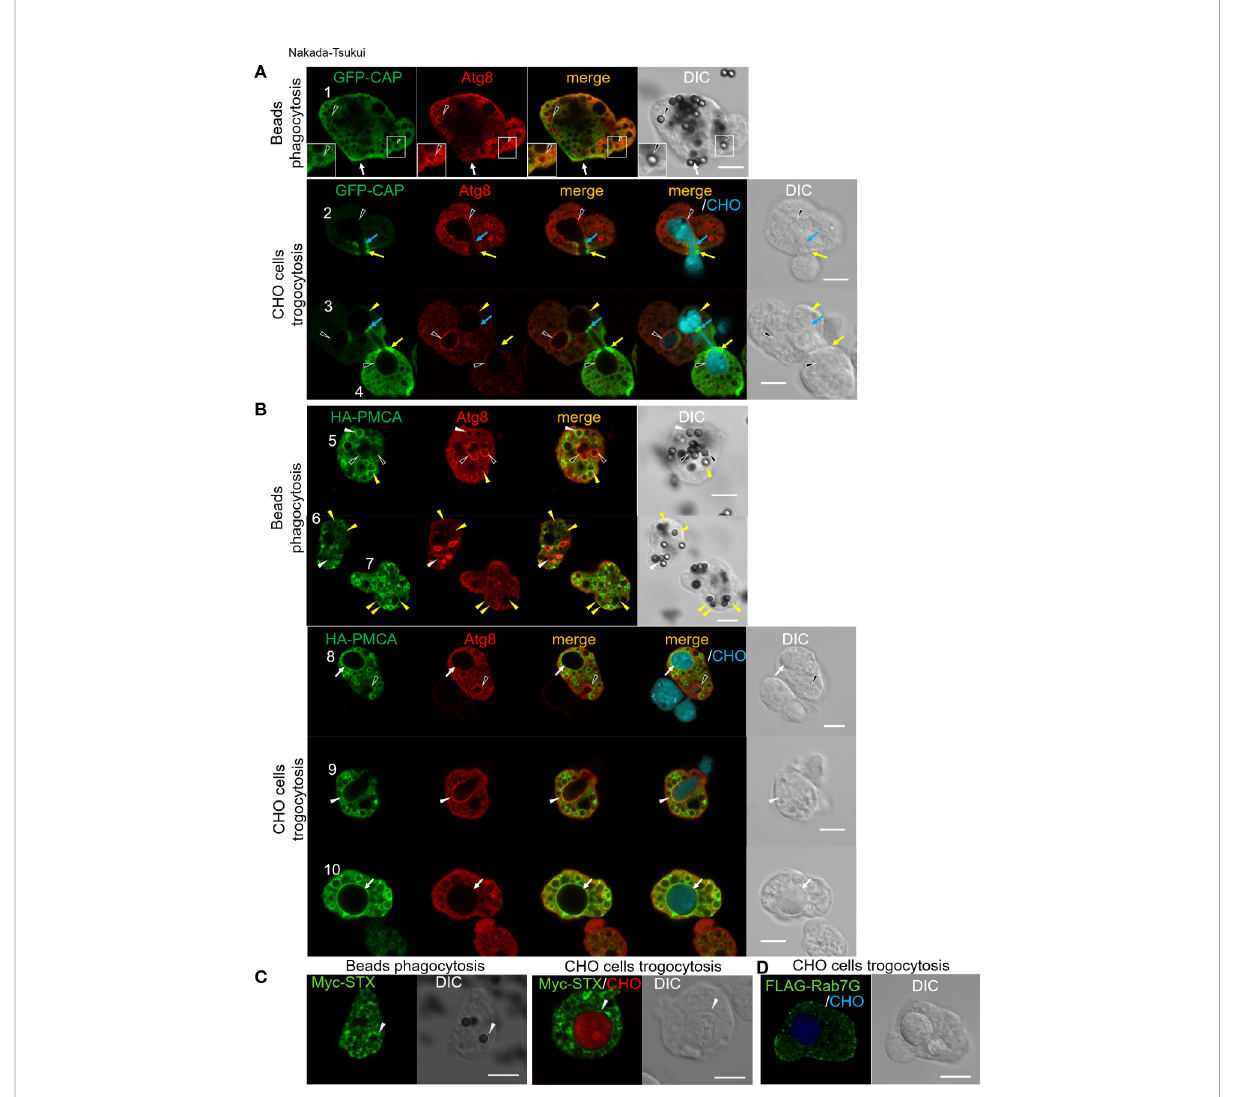
FIGURE 3 Subcellular localization of newly identi fi ed phagosomal proteins. Subcellular localization of tag-fused CAP (A) , PMCA (B) , STX (C) , and Rab7G (D) were shown in green (GFP or AlexaFluor 488). (A) GFP-CAP expressing E histolytica trophozoites were co-incubated with human serum coated beads for 30 min (upper panels) or CellTracker Blue-stained live CHO cells for 30 min (lower panels). Cells were fi xed and localization of self- fl uorescence of GFP and anti-Atg8 antibody stained Atg8 (Alexa Fluor 568) were shown. Black arrowheads, CAP negative Atg8 positive phagosome/ trogosome; yellow arrowheads, CAP and Atg8 double-negative trogosome; white arrow, uningested beads bound CAP accumulated region; yellow arrows, CAP accumulated live CHO pinching-off site at amoeba surface; blue arrows, CAP accumulated closure site at internal trogosome. (B) HA-PMCA expressing E histolytica trophozoites were co-incubated with human serum coated beads for 30 min (upper panels) or CellTracker Blue-stained live CHO cells for 30 min (lower panels). Cells were fi xed and HA fusion protein and Atg8 were visualized with anti-HA and anti-Atg8 antibodies with Alexa Fluor 488 and 568 conjugated secondary antibodies, respectively. Black arrowheads, PMCA negative Atg8 positive phagosome/trogocytic cup; white arrowheads, PMCA and Atg8 double-positive phagosome/trogocytic cup; yellow arrowheads, PMCA positive Atg8 negative phagosome; white arrows, PMCA positive Atg8 negative trogosome. (C) Myc-STX expressing E histolytica trophozoites were co- incubated with human serum coated beads for 30 min (left panels) or CellTracker Blue-stained live CHO cells for 15 min (right panels). Cells were fi xed and Myc fusion protein was visualized with an anti-Myc antibody with Alexa Fluor 488 conjugated secondary antibody. White arrowheads, STX positive phagosome/trogosome. (D) FLAG-Rab7G expressing E histolytica trophozoites were co-incubated with CellTracker Blue-stained live CHO cells for 15 min. Cells were fi xed and the FLAG fusion protein was visualized with anti-FLAG antibody with Alexa Fluor 488 conjugated secondary antibody. Bars, 10 m